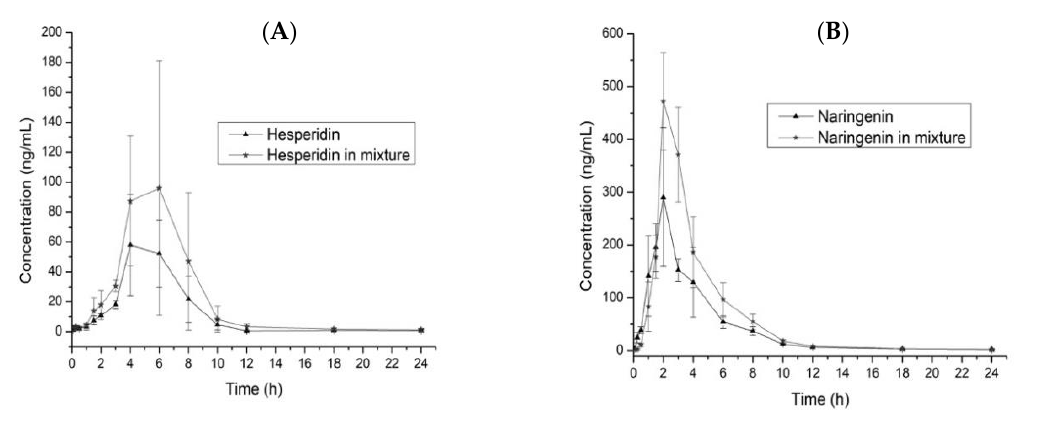
Figure 3. Comparison of the plasma concentration time-curves for Hsn and Hsn / Ngn ( A ) and Ngn and Ngn / Hsn ( B ). Values are expressed as the mean ± SD.